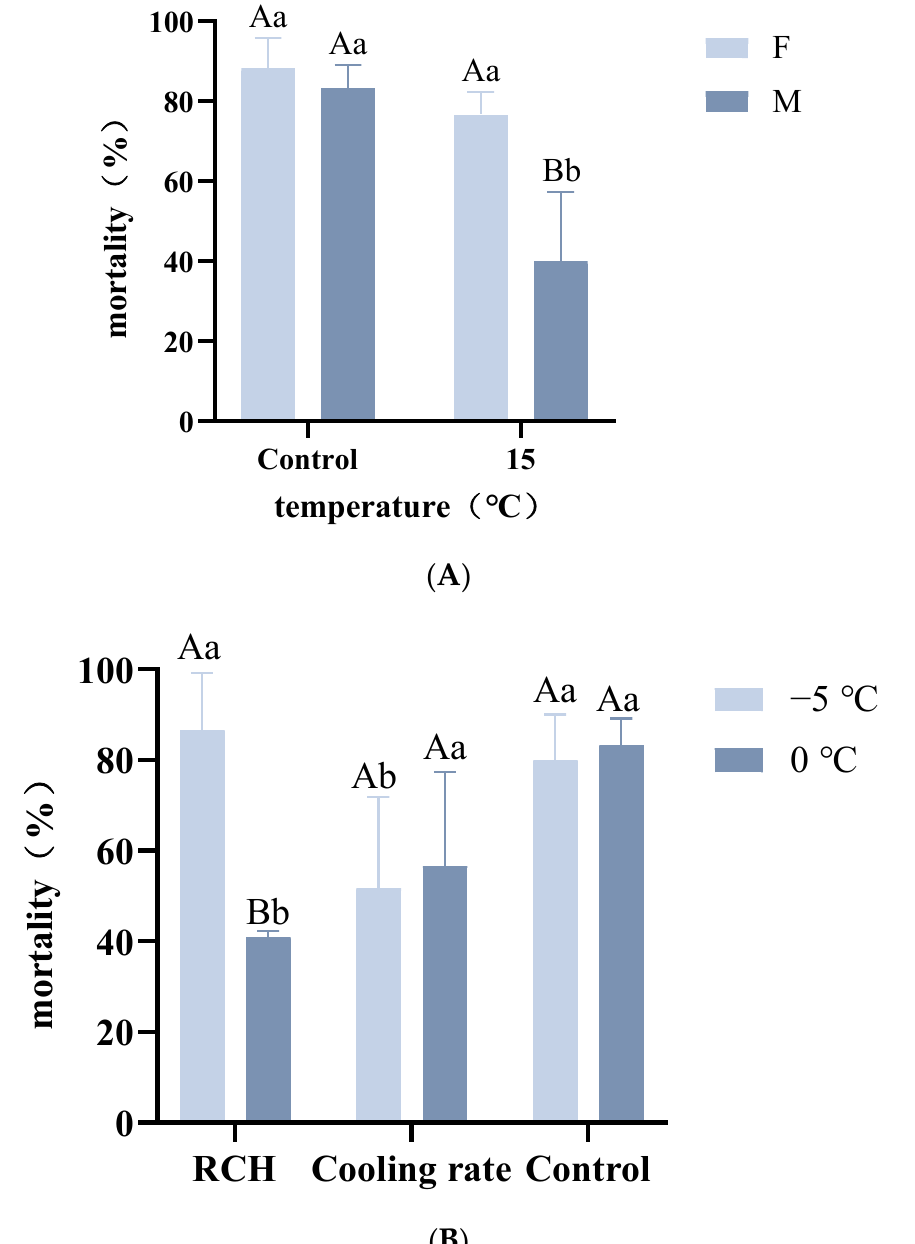
Figure 4. The mortality of Agasicles hygrophila adults acclimated using different procedures. ( A ) Mortality of A. hygrophila adults at the identification temperature after long-term acclimation compared with that of untreated controls. ( B ) Mortality of A. hygrophila adults after rapid cold hardening (RCH) and gradual cooling at 0 and 5 °C. Control insects were directly exposed to − 10 °C for 2 h without pre-exposure cold acclimation. Capital letters refer to the differences in the mortality of A. hygrophila following treatment with the same temperature for different genders. Lowercase letters refer to the differences in the mortality of A. hygrophila following treatment with different temperatures for the same gender. Differences in mortality were analyzed using repeated-measures ANOVA, followed by the LSD test ( p < 0.05). All values are presented as the mean ± SE.